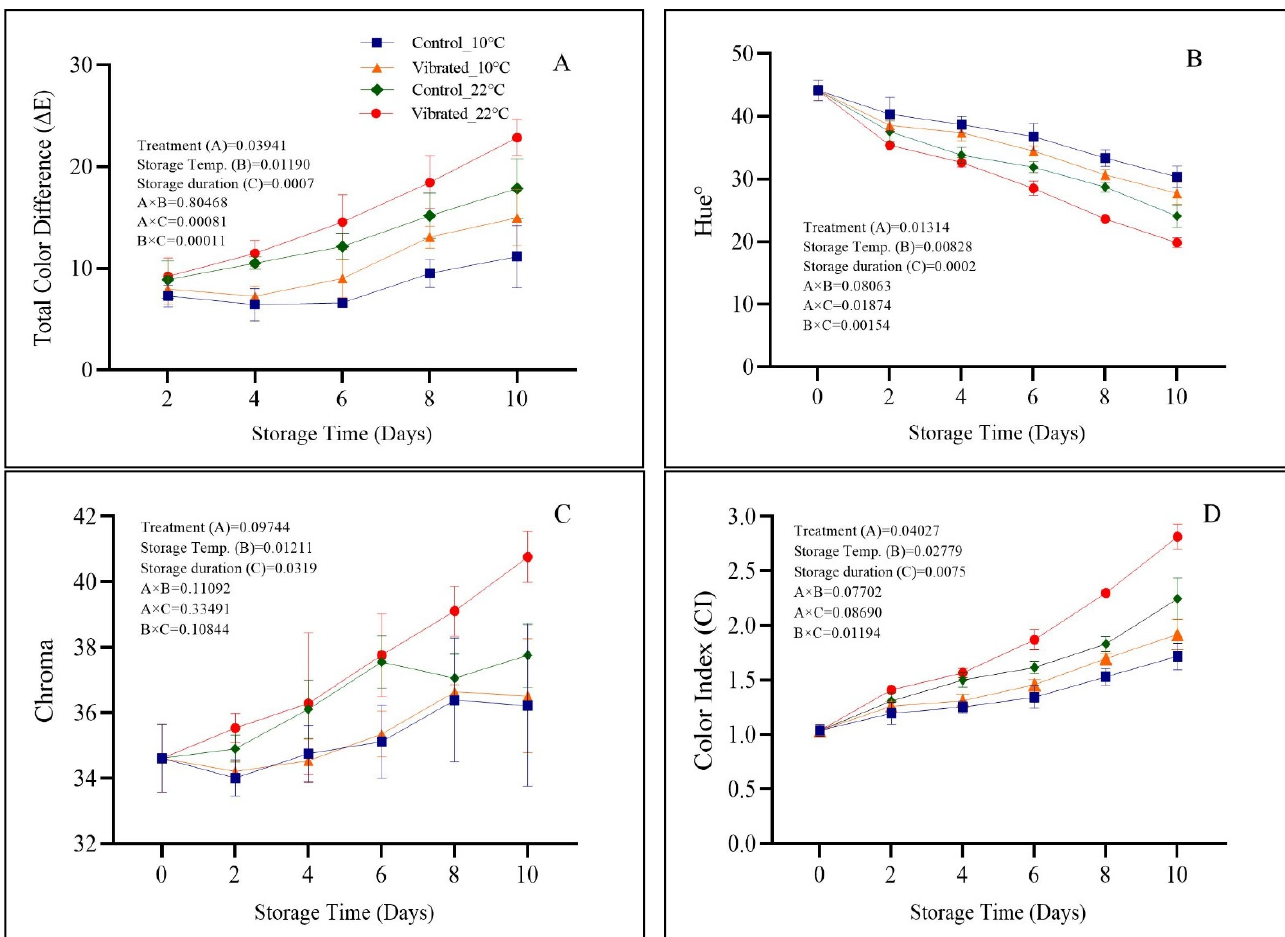
Figure 9. ( A ) Total color difference ( ∆ E), ( B ) hue angle (hue°), ( C ) chroma, and ( D ) tomato color index (CI) value of vibrated and non-vibrated (control) tomatoes stored at 10 °C and 22 °C for 10 days storage. Error bars represent the standard deviation (SD) of the mean values ± S.D 15 readings per 3 replicates.